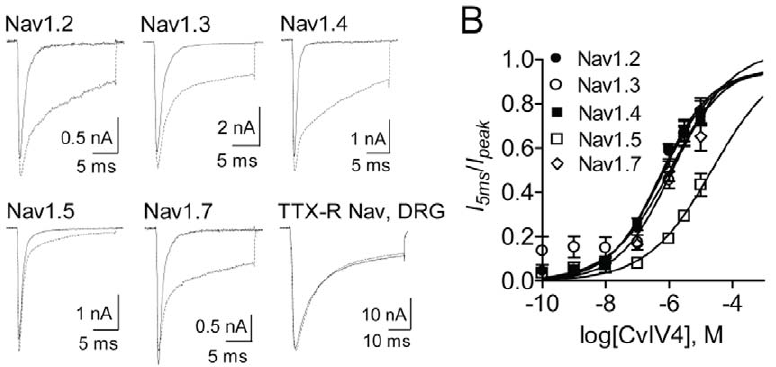
Figure 6. Effects of toxin CvIV4 on voltage-gated sodium channel isoforms. A. CvIV4 (1 m M) slowed the fast inactivation of isoforms Na v 1.2, Na v 1.3, Na v 1.4 and Na v 1.7 expressed in human embryonic kidney cells (HEK). In contrast, CvIV4 had a minimal effect on Na v 1.5 (expressed in HEK) and no effect on neuronal TTX-R sodium current isolated from adult rat dorsal root ganglia (DRG) neurons (500 nM TTX was used to block TTX-S sodium current). All sodium current traces were elicited by depolarizing to 2 10 mV from a holding potential of 2 100 mV. B. Dose-response curves for CvIV4 slowing the fast inactivation of five sodium channel isoforms (Na v